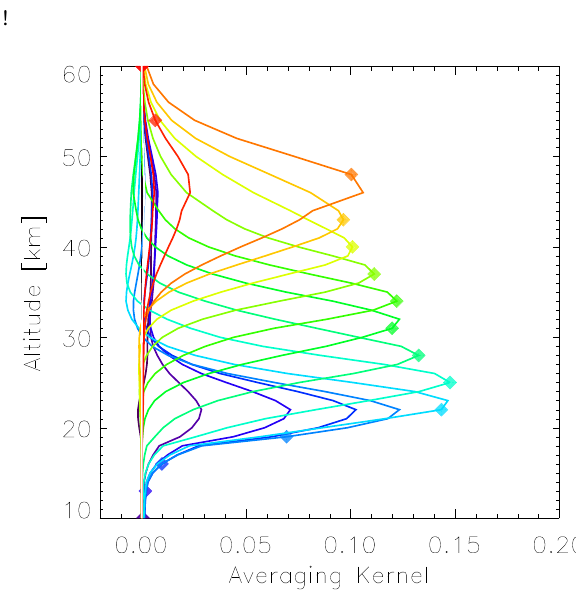
Fig. 1. Averaging kernels of MIPAS HOCl measurements. Dia- monds represent the nominal altitudes (i.e. the diagonal value of the averaging kernel matrix). For clarity, only every third averaging kernel is shown. This example refers to a profile measured during night at 27.9 ◦ S, 86,2 ◦ E on 1 January 2003, 16:34 UT.